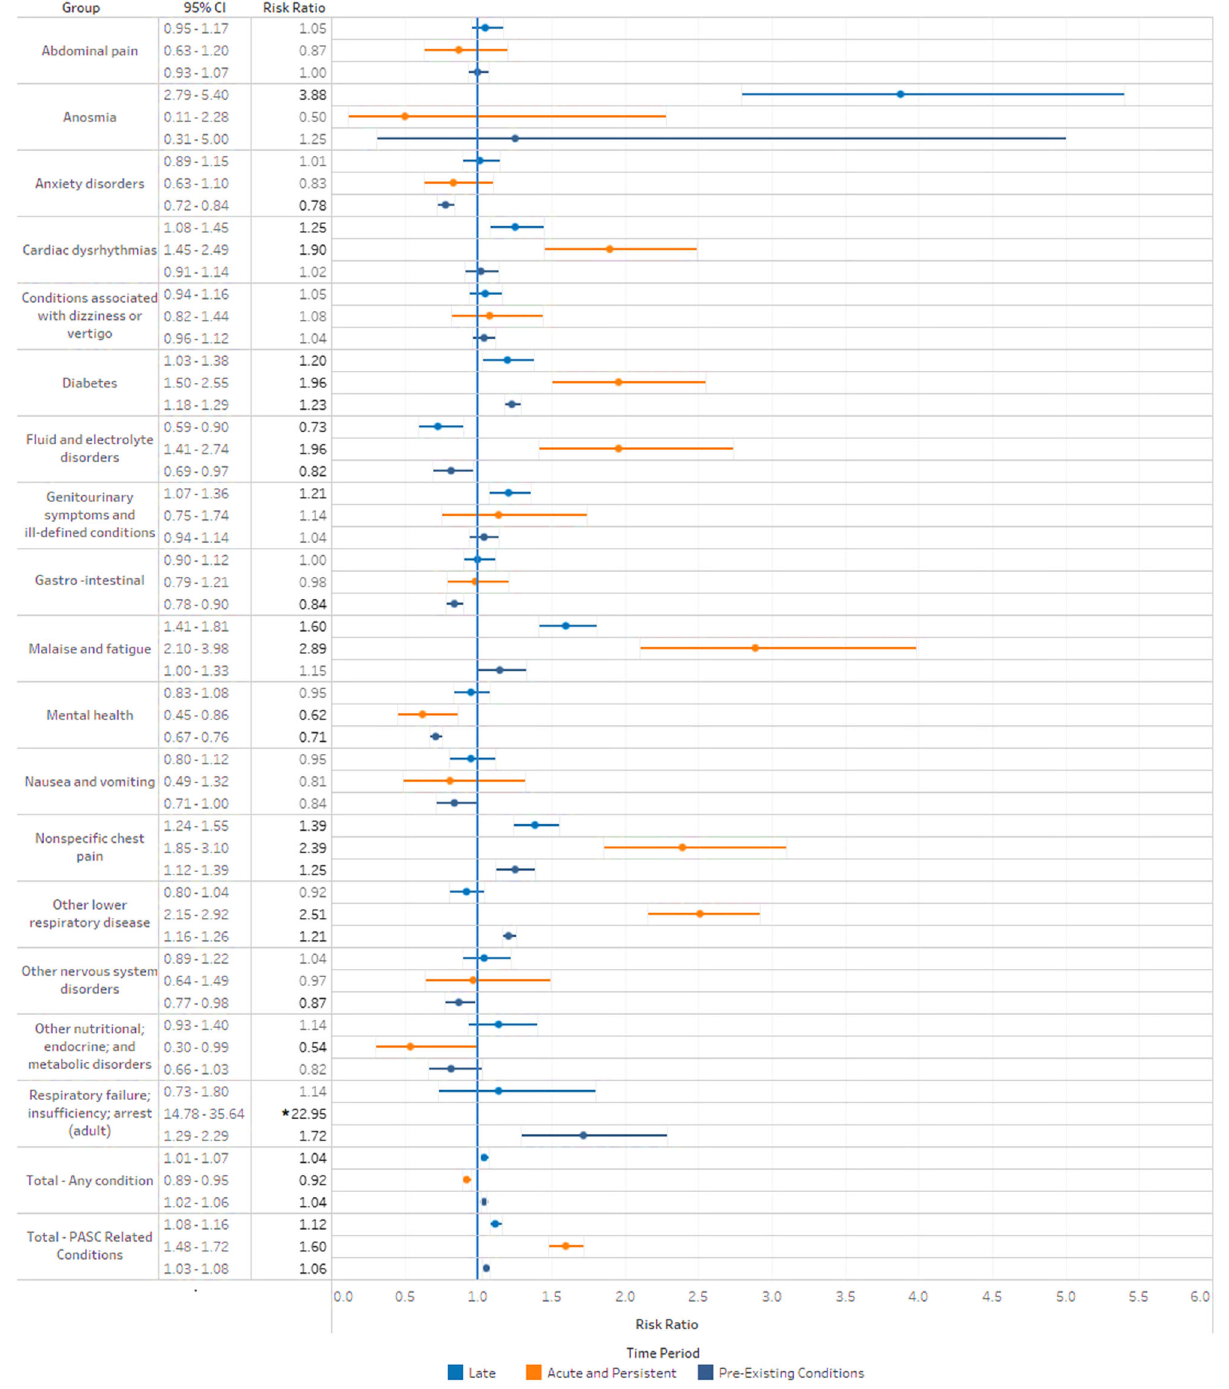
Fig. 1 | Unadjusted risk ratios (and 95% con fi dence intervals) of PASC-related conditions comparing PCR-positive (vs. PCR-negative), in three-time periods anchored on the date of SARS-CoV-2 PCR test result. A CCS condition risk ratio comparison with a 95% CI plot for PCR-positive population vs PCR-negative population within our study time periods. Risk ratio is the measure of interest comprised of the number of CCS conditions incident in the PCR-positive cohort